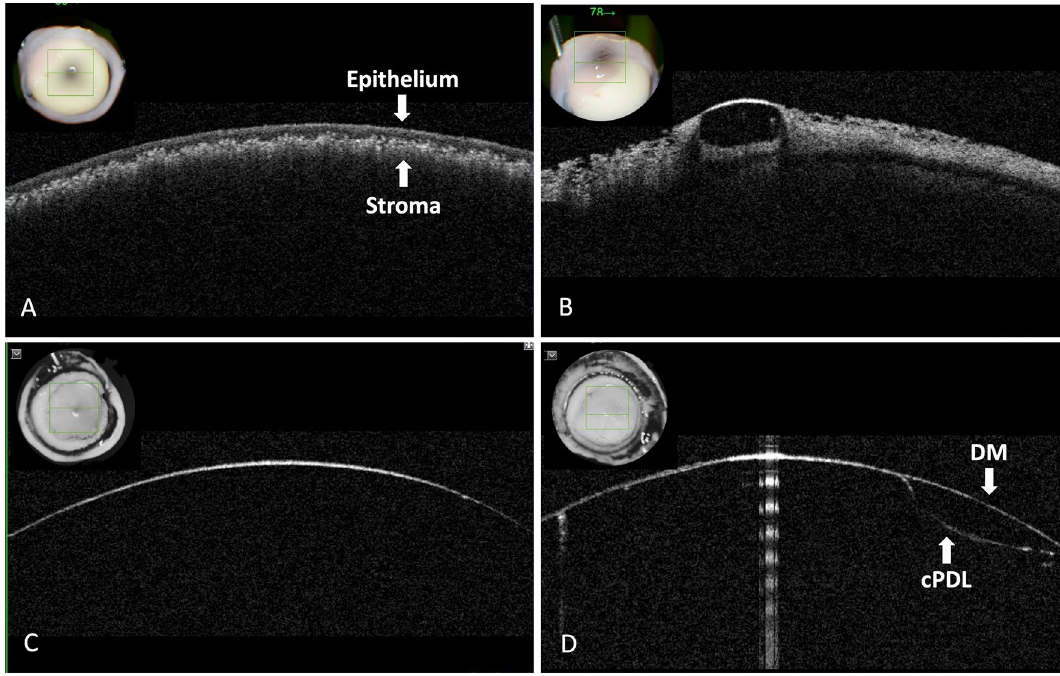
Figure 2. Anterior segment optical coherence tomography (AS-OCT) (Topcon Europe medical BV, Netherland) of the canine corneas after intrastromal air injection. ( A ) Anterior scan from the epithelial surface. The epithelium is demarcated from the underlying hyper-reflective aerated stroma. ( B ) Air has entered the epithelium creating and air vesicle. ( C ) Scan performed from the posterior surface of the cornea after creating a type 1 big bubble (BB). The posterior wall of the type 1 BB made of the canine pre-Descemet’s layer (cPDL) and Descemet’s membrane (DM). The AS-OCT scan does not distinguish between the two layers. ( D ) Similar scan as in ‘C’ of a type 1 BB. On the right side, the DM was peeled off over a section of the bubble and replaced prior to the scan. The anterior DM and posterior cPDL are clearly visible but are indistinguishable in the left two thirds of the scan where the DM and cPDL are closely